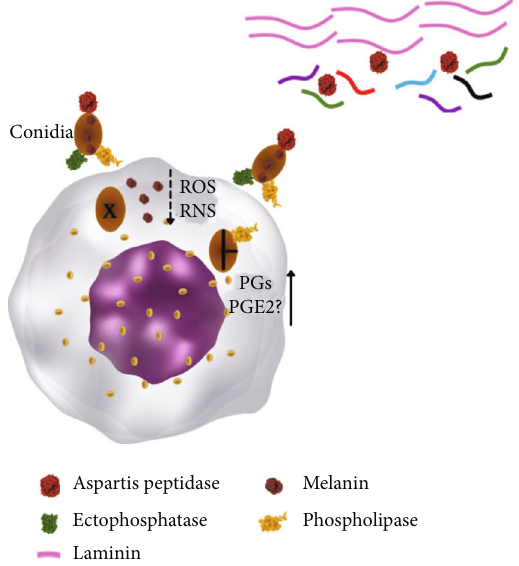
Figure 3: Interaction between the etiologic agents of CBM and phagocytic cells. The ectophosphatase enzyme is involved in the cell adhesion of conidia in the cell membrane of cells, and phospholipase may aid the process of cell invasion through digestion of lipids. In the intracellular environment, conidia di ff erentiate into muriform cells, and released melanin with unpaired electrons has the ability to inhibit phagocytosis as well as scavenger ROS and NOS. Furthermore, some types of phospholipases induce the production of prostaglandins (PG), such as prostaglandin E2 (PGE2), which has a suppressive e ff ect on macrophages. Extracellular fungi (such as muriform cells or conidia) secrete aspartic peptidase that is capable of cleaving laminin in connective tissues, ensuring that fungi spread through